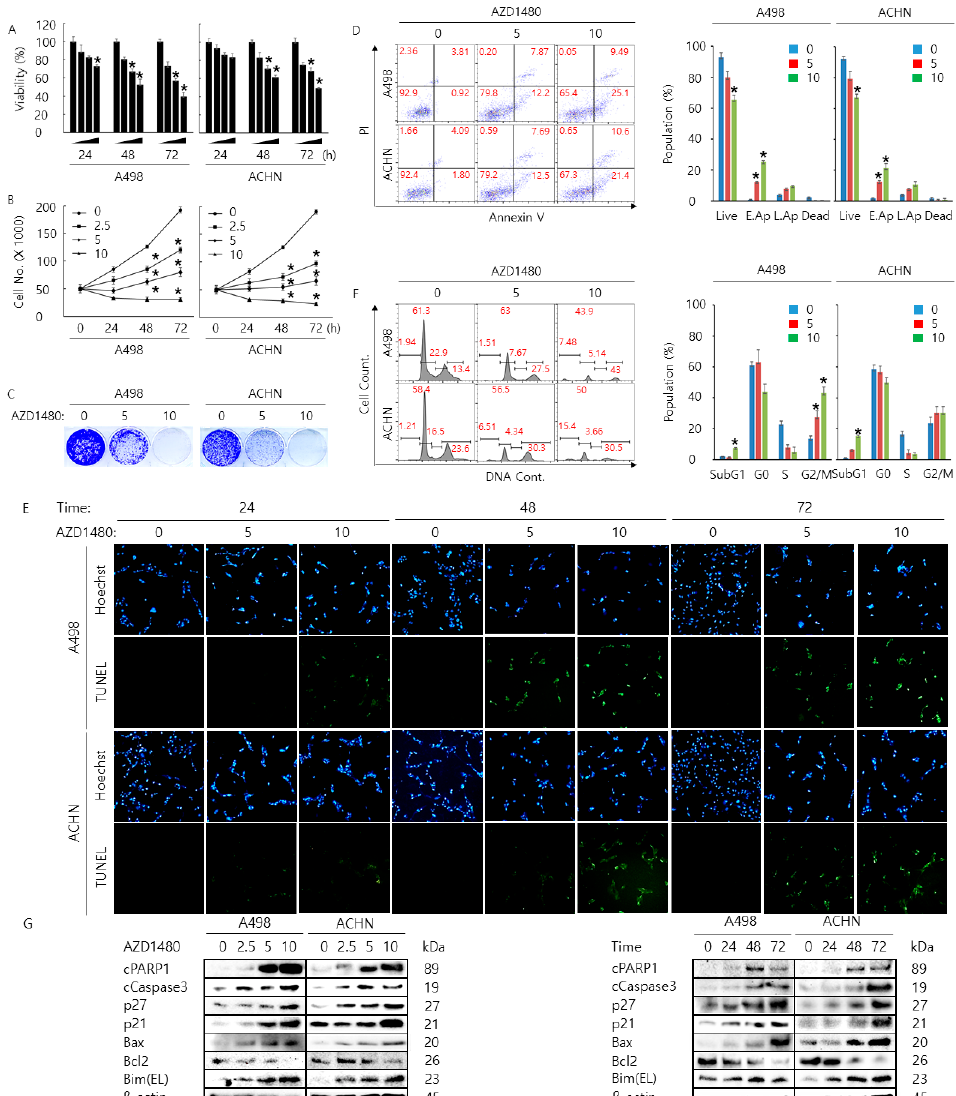
Figure 5. Anti-cancer effect by AZD1480 treatment in A498 and ACHN cells. ( A ) Dose and time- dependent anti-cancer effect by the indicated concentration of AZD1480 treatment in A498 and ACHN cells for 24, 48, and 72 h. Cell viability and proliferation rate was determined by WST-1 assay ( A ) and cell counting assay ( B ), respectively. This result is representative data from three biological replicates, and the error bar indicates standard error (STE). * indicates the p -value < 0.05. ( C ) Anti- colony formation ability by the indicated concentration of AZD1480 treatment in A498 and ACHN cells was determined by colony formation assay for 14 days. This result is representative data from three biological replicates. Apoptosis in A498 and ACHN cells treated by the indicated concentration of AZD1480 was determined by Annexin V staining analysis ( D ) and TUNEL assay ( E ). Live: live cells, E.Ap: early apoptotic cells, L.Ap: late apoptotic cells, and dead: dead cells. Cell cycle arrest was determined by cell cycle analysis ( F ). These results are representative data from three biological replicates. ( G ) Dose and time-dependent western blotting analysis of proteins related to apoptosis and cell cycle arrest in A498 and ACHN cells treated by the indicated concentration of AZD1480. β - actin was used for a gel-loading control. Magnification for ( E ): ×20.